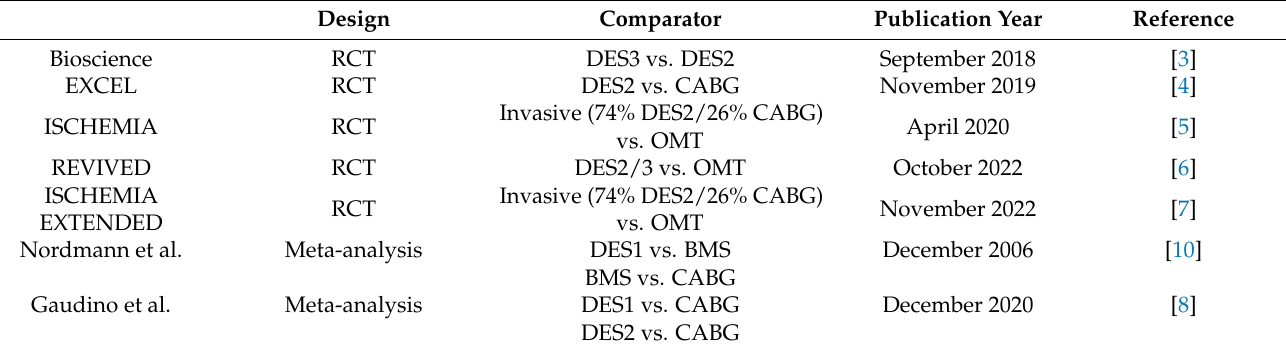
Table 1. Randomized studies and meta-analyses with DES report a high incidence of NCD and/or cancer.